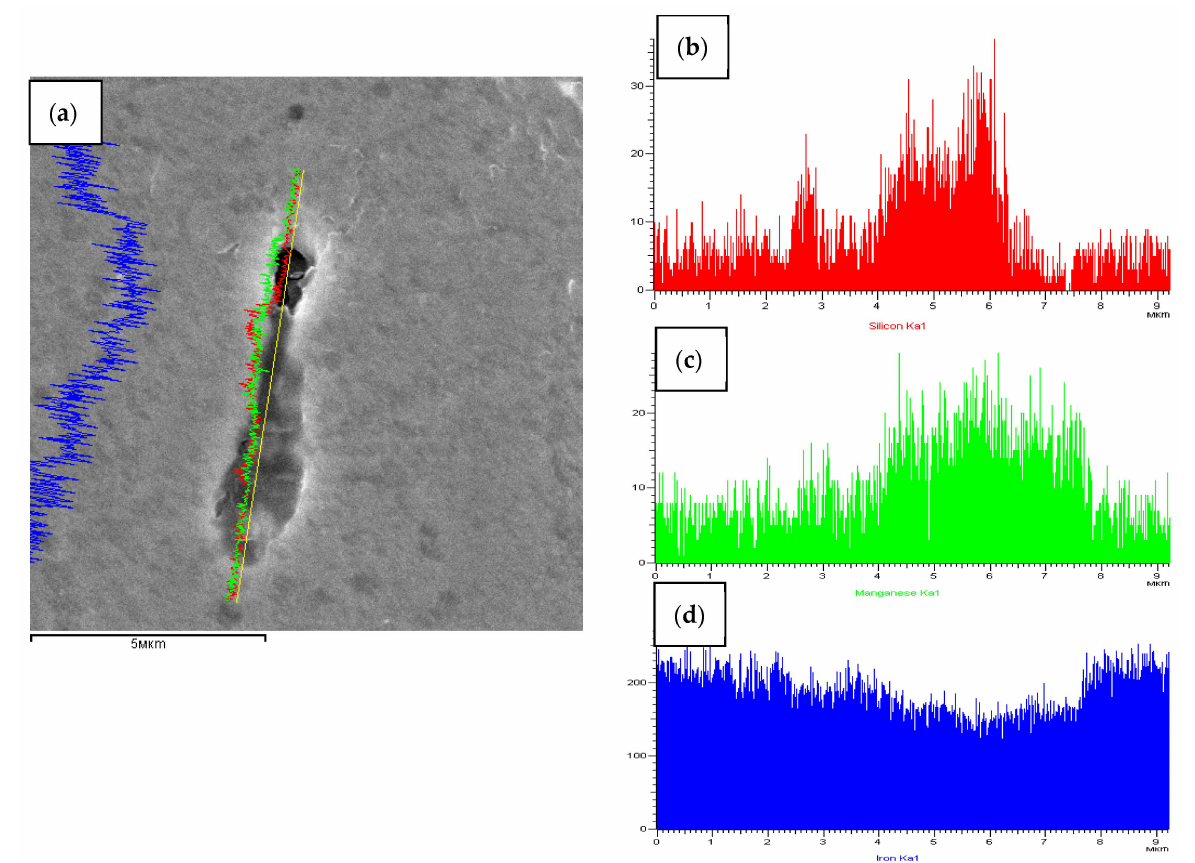
Figure 5. The qualitative analysis of channel element of the structure of steel St3 after the dynamic alloying in the SDP mode: ( a ) Channel element (fiber) in the structure steel St3 after the dynamic alloying in the SDP mode; concentration curves of elemental distribution: ( b ) Silicon, ( c ) Magnesium and ( d ) Iron.